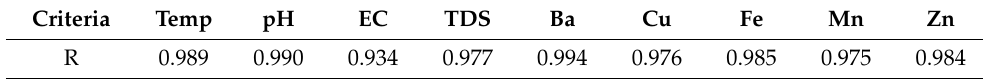
Table 6. Cross Validation Results for NN-PSO+EBK simulation.